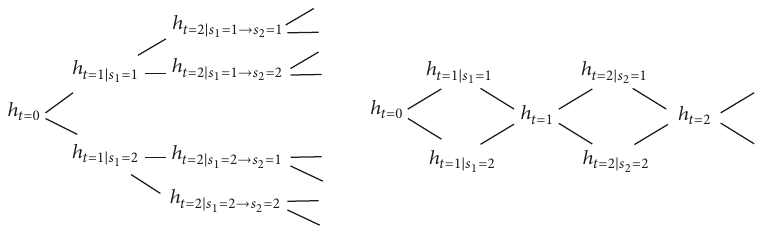
Figure 1: The path change of conditional variance.